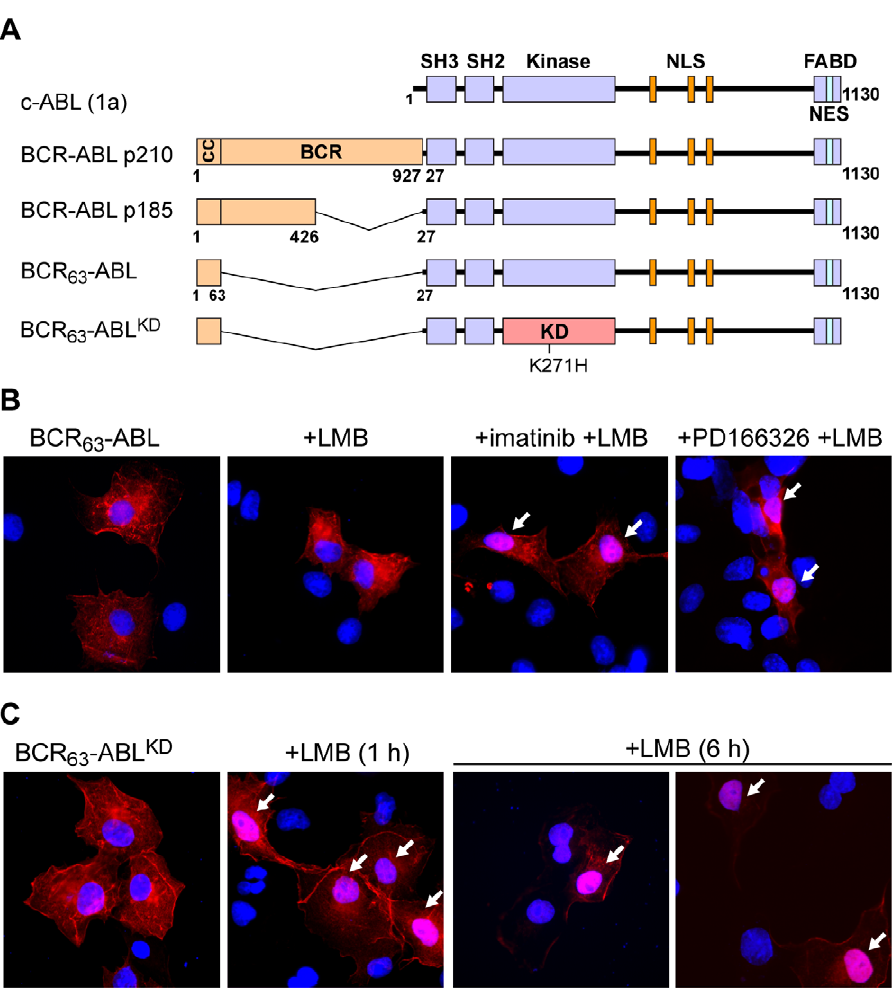
Figure 1. Kinase activity of BCR-ABL inhibits its nuclear import. A : Domain structure of ABL, the BCR-ABL p210 and p185 fusion proteins, and the minimal BCR 63 -ABL used in this study. All numbering used herein refers to amino acid positions in the human ABL-1a isoform. The kinase- defective (KD) constructs bear a lysine-to-histidine substitution (K271H) in the ATP-binding site, which renders the kinase catalytically inactive. Abbreviations used are: SH3, src-homology 3; SH2 src-homology 2; FABD, F-actin binding domain; NLS, nuclear localization signal; NES nuclear export signal; cc, coiled-coil oligomerization domain; KD, kinase-defective. B and C : COS cells ectopically expressing active BCR 63 -ABL ( B ) or the kinase- defective mutant (BCR 63 -ABL KD ) ( C ) were treated with the CRM1-inhibitor LMB (10 nM) for either 1 or 6 hours, which leads to accumulation in the nuclei of cells only if the protein is imported. The presence of nuclear staining in LMB-treated cells demonstrates that the protein is imported. Cells displaying notable nuclear staining (resulting from nuclear import) of BCR-ABL are marked with white arrows. The BCR-ABL kinase activity was also blocked by treatment with the kinase inhibitors imatinib (10 m M) or PD166326 (10 nM) for 16 hours to enable nuclear import. BCR-ABL localization was determined by immunofluorescence staining with an anti-ABL antibody (8E9, shown in red). The endogenous ABL was not observed under the experimental conditions, which were designed to detect only the ectopically expressed proteins that were present at a much higher abundance than the endogenous ABL protein. DNA is counterstained in blue with Hoechst dye.